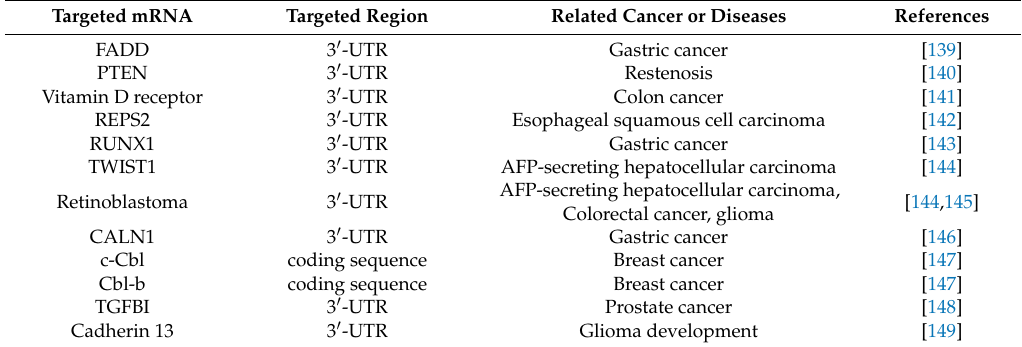
Table 3. Targets of